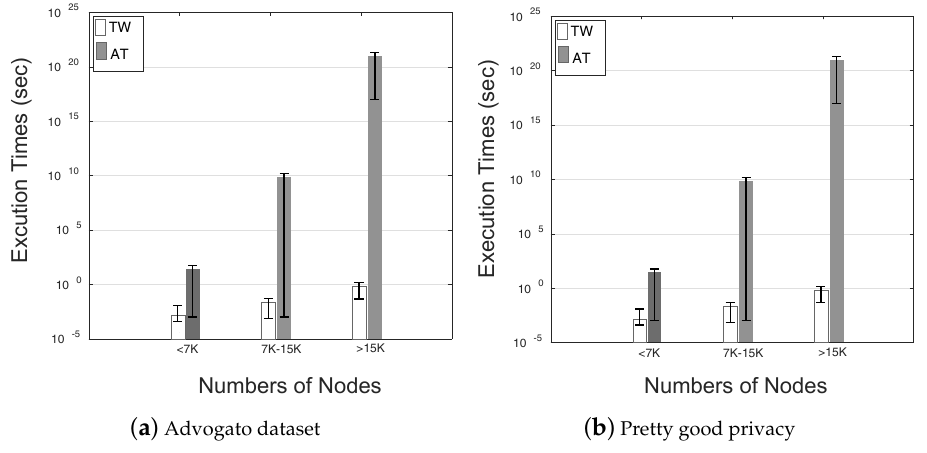
Figure 8. Execution time of AT and TW